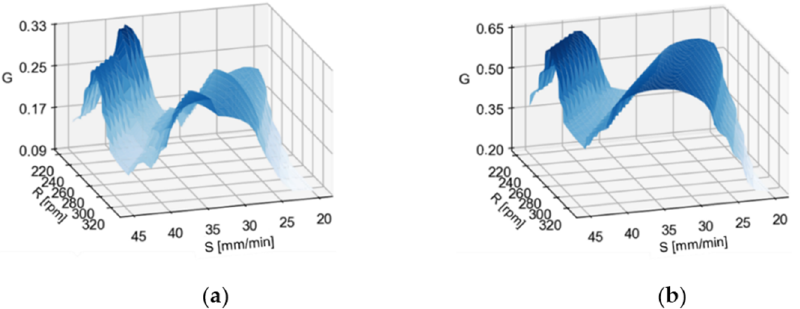
Figure 9. Graphs of the global preference function for ( a ) the variant CV and weights W_ALL and ( b ) CMV and weights W_Z; with H = 1 fixed.